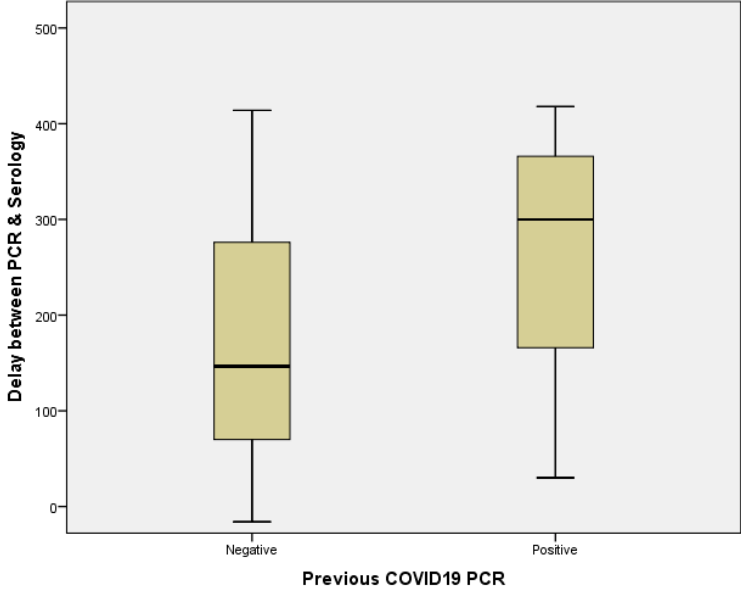
Figure 1. Seroprevalence and clinical characteristics.